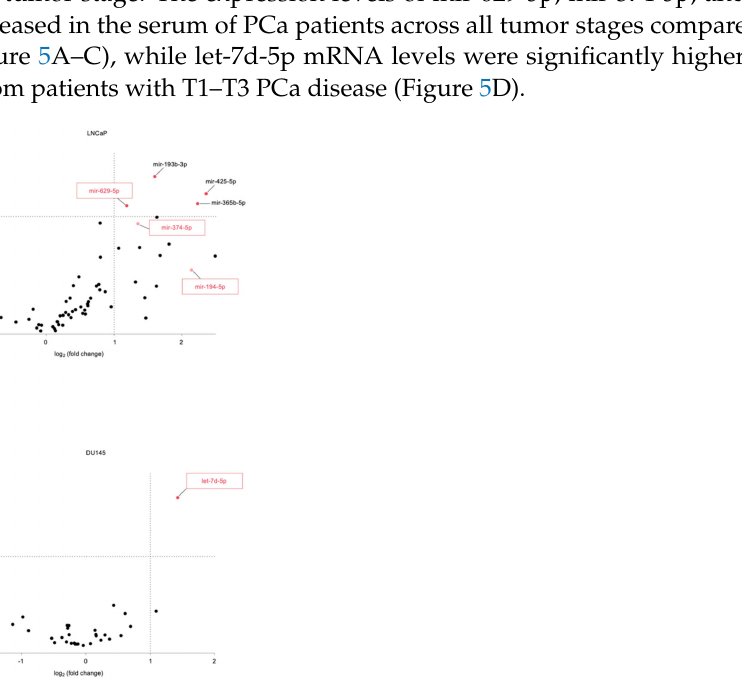
Figure 2. Extracellular miRNAs profiling of US-treated PCa cells. ( A , B ) Volcano plots showing the profiles miRNAs released in ( A ) LNCaP or ( B ) DU145 supernatants after US treatment relative to those of untreated control cells, performed by using TaqMan™ Advanced miRNA Human Serum/Plasma Card RT-qPCR array cards. The analyses were performed using Expression Suite software. Reported are the negative log10 p -values plotted against the log2 fold change. Dots represent individual miRNAs. Horizontal line, p = 0.05; Vertical line, FC = 2. Dark red dots, miRNAs released at significantly higher levels ( p < 0.05). miRNAs of interest are depicted (framed